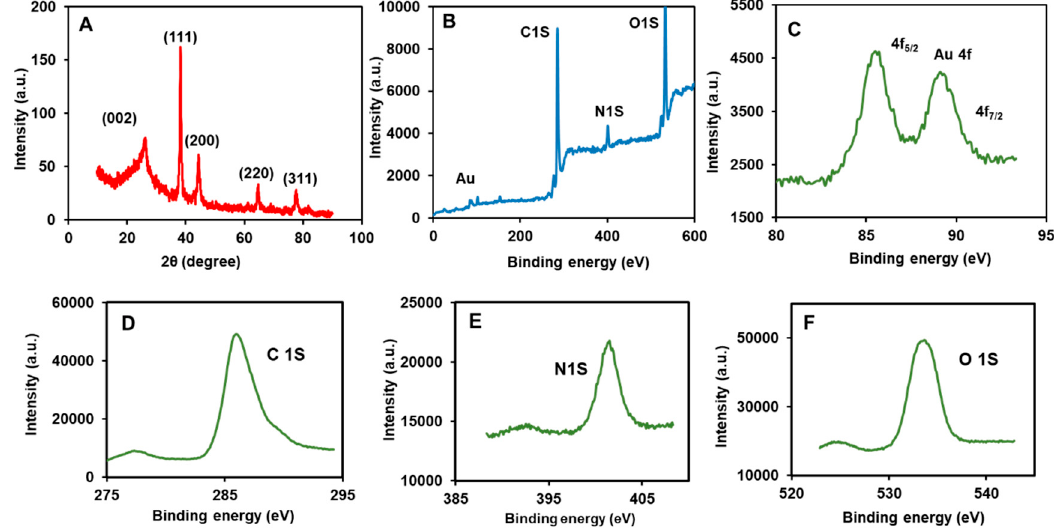
Figure 2. ( A ) X-ray diffraction patterns, ( B ) X-ray photoelectron spectroscopy (XPS) survey spectrum, and ( C – F ) XPS relevant to each atom of the CNTs / PDA / AuNPs nanocomposite. Int. J. Mol. Sci. 2020 , 21 , x FOR PEER REVIEW